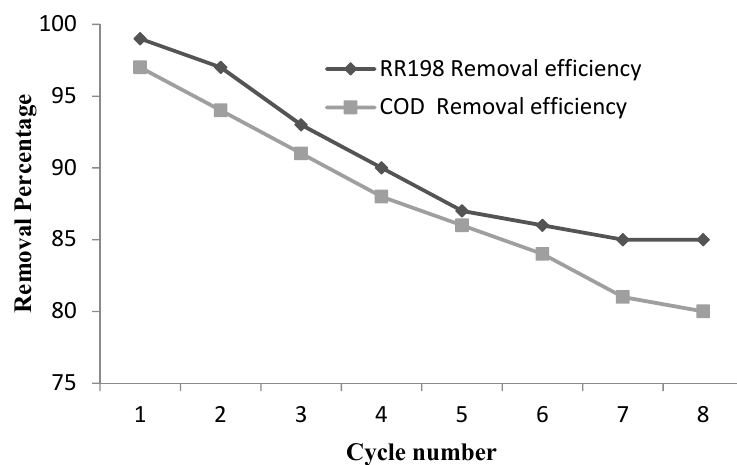
Figure 10. Stability of AC/CFO nanocomposite in cycle experiments RR198 and COD removal.